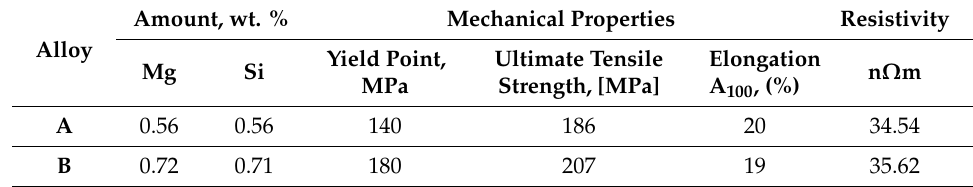
Table 2. Properties of the Al-Mg-Si wire rod with di ff erent Mg and Si amounts. Amount, wt. Alloy